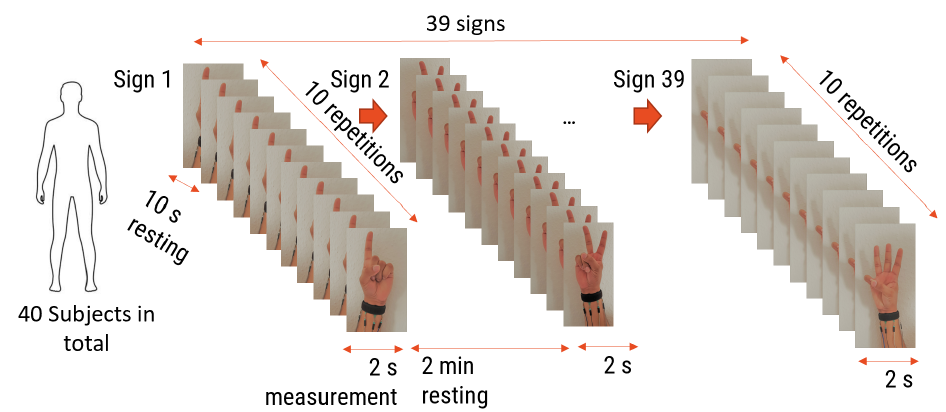
Figure 2. FMG signal collection protocol.